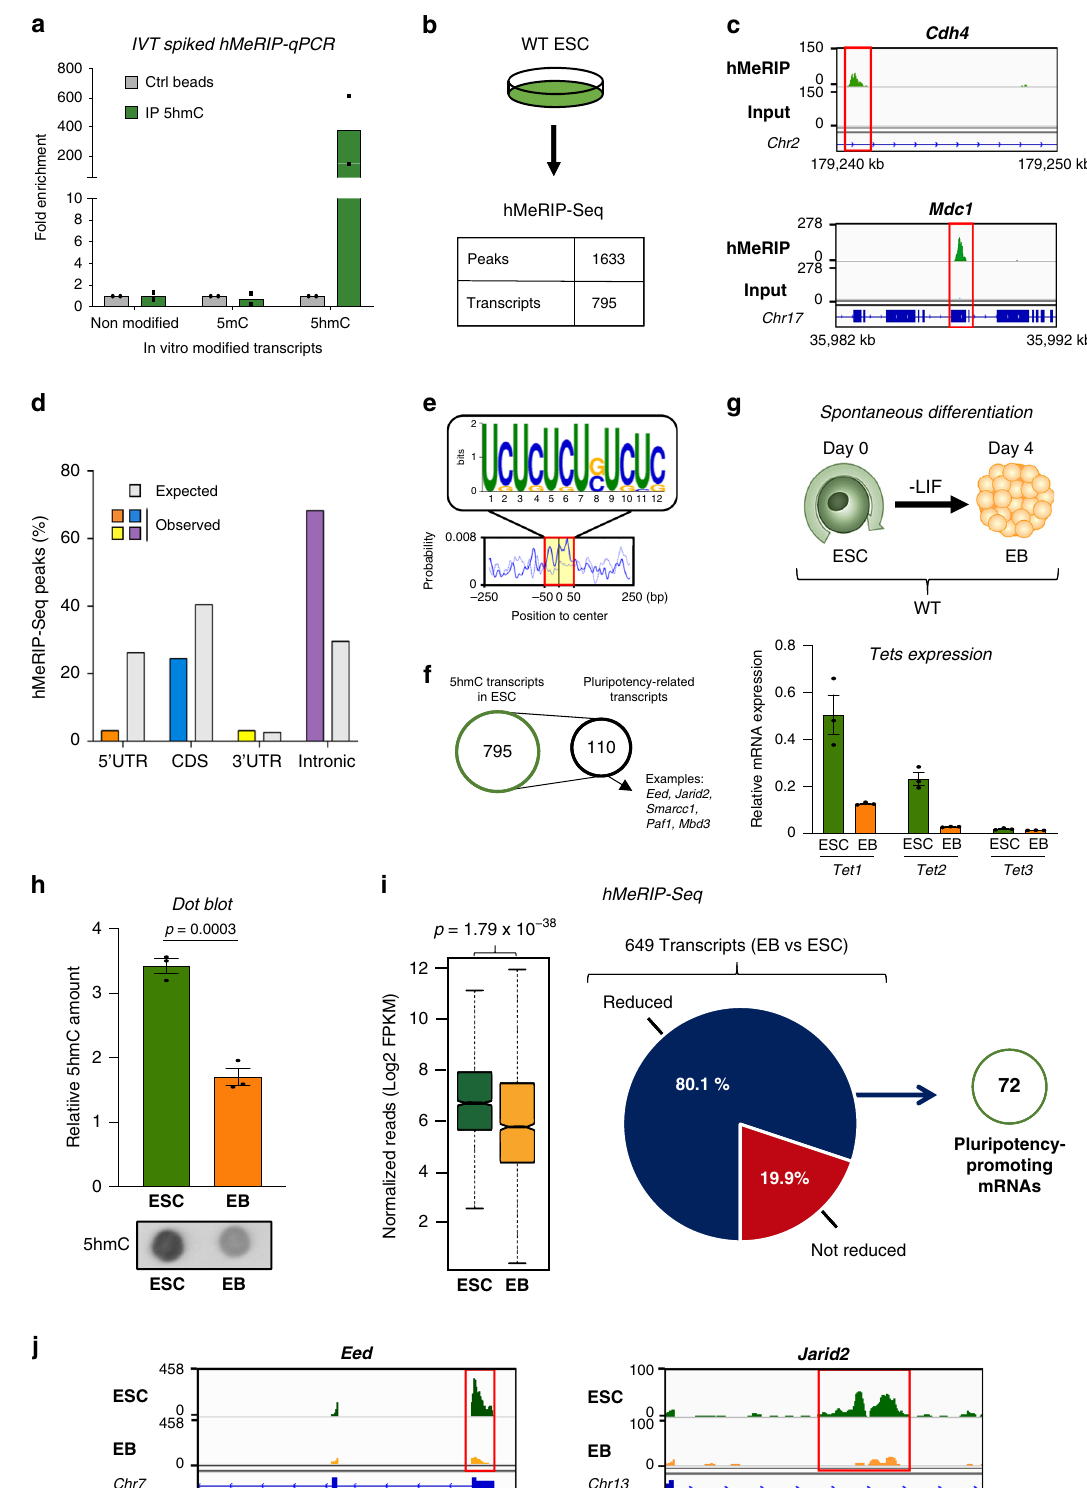
ESCs 37 . Dot blots for Tet1- and Tet2 -depleted ESCs (DKO) showed a reduction of the 5hmC level similar to that observed for TKO ESCs, while dot blots for Tet3 KO ESCs showed no